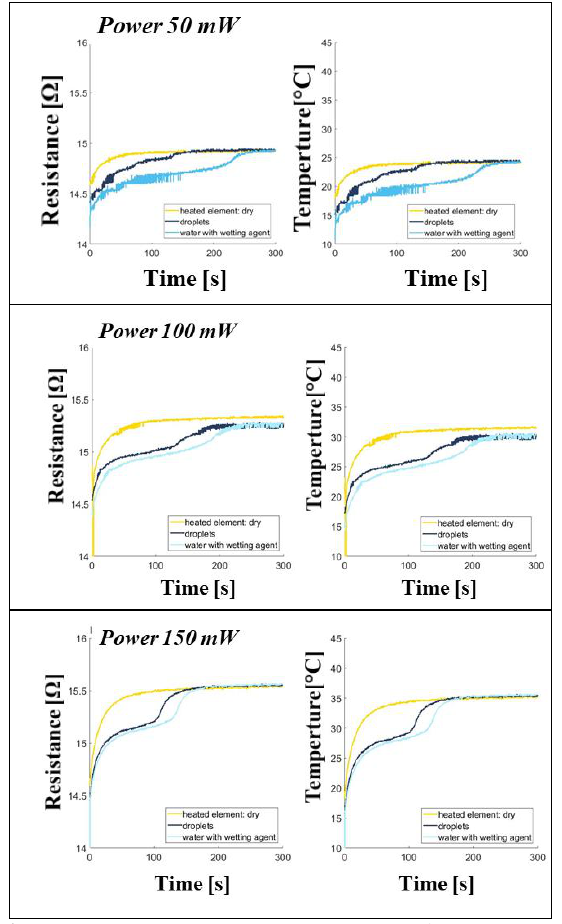
Fig. 16. Resulting resistance and temperature for three sets of power on heated element in configuration: dry, with droplet attached to the surface and with the water film covering the element.